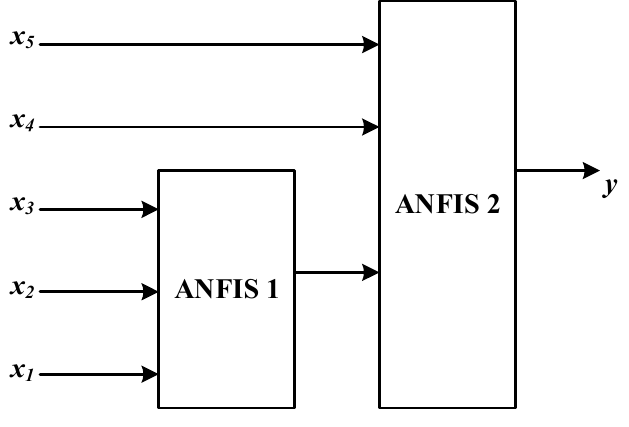
Fig. 13. The HANFIS structure for proposed